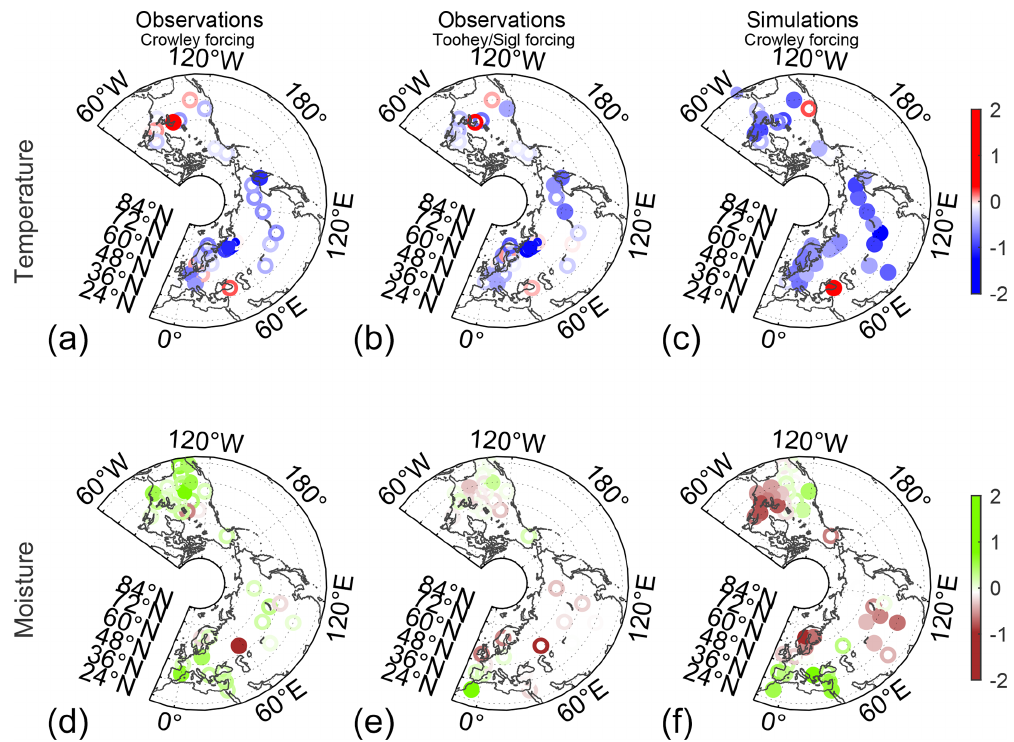
Figure 6. Composite average ring width anomaly (standardized units) in temperature-sensitive TRW chronologies in the first 2 years after volcanic eruptions in observations and volcanic-forcing simulations (a, b, c) . Because relatively few TRW records are available for 1400– 1700 (Fig. 2), the composite includes the seven strongest eruptions between 1670 and 1970 based on the eruption chronologies of Crowley et al. (2013) (a, d, c, f) and Sigl et al. (2015) (b, e) . Panels (d) , (e) , (f) are the same as panels (a) , (b) , (c) but for moisture-sensitive TRW observations and simulations. Closed circles indicate statistical significance ( p values of t test < 0 . 05).